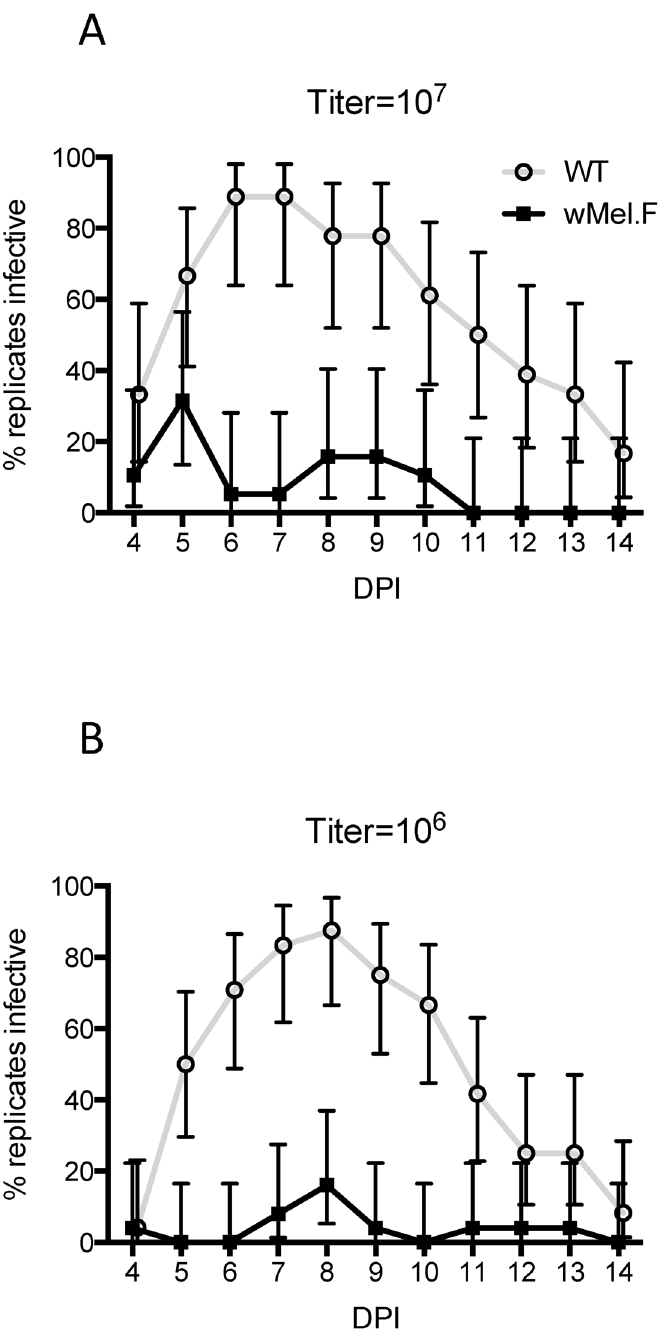
Fig 5. Percentage of replicates infective through time ± confidence intervals for WT (grey line) and w Mel.F mosquitoes (black line) orally infected with either 10 7 (A) or 10 6 (B) PFU/ml of DENV.